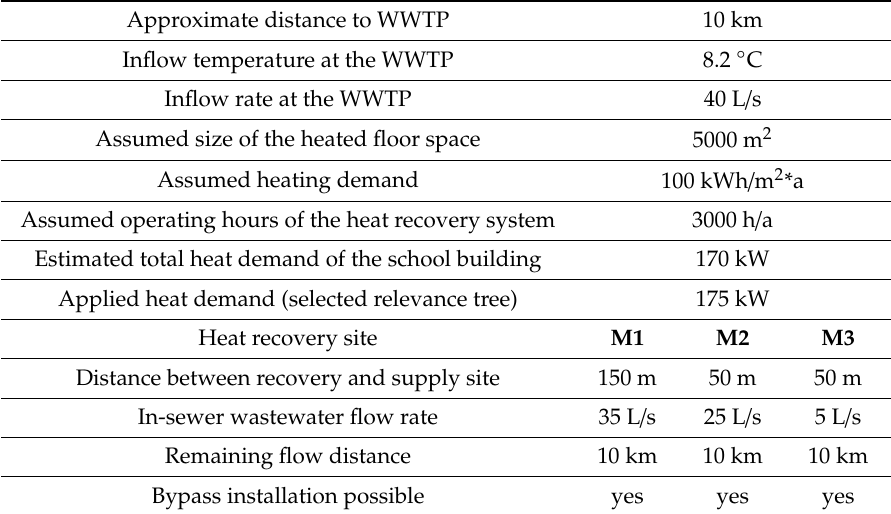
Table 3. Collected data and information of the case study application (own